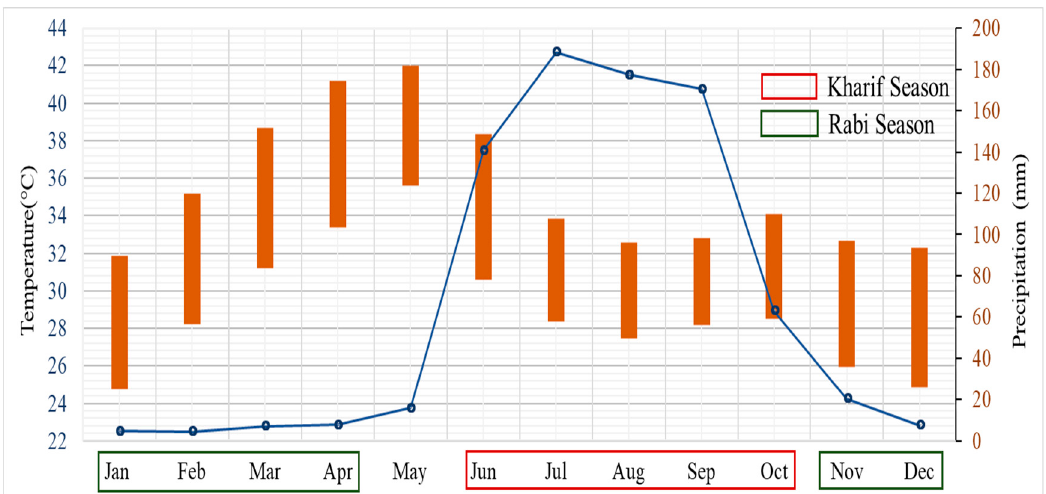
Figure 2. Indian Meteorological Department (IMD)-based long-term average monthly temperature and precipitation in Marathwada.